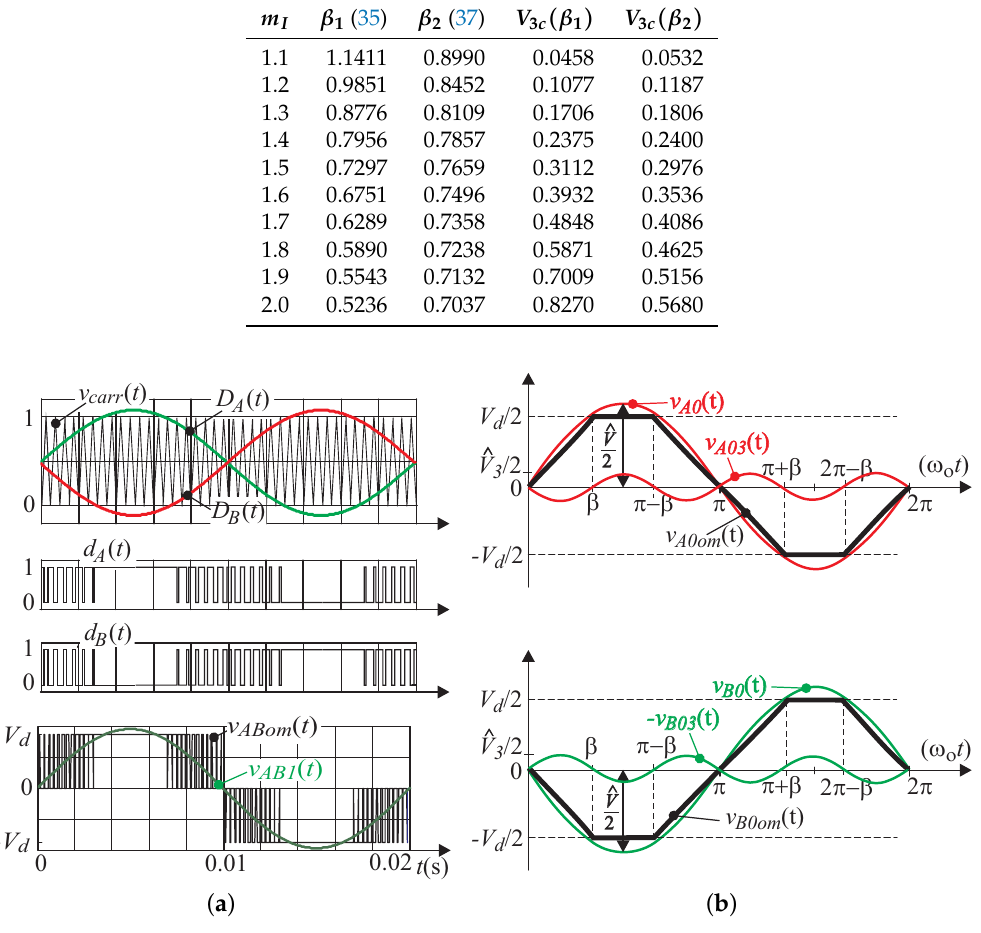
Figure 5. Over-modulation procedure: ( a ) Triangular carrier signal and duty cycle functions D A ( t ) and D B ( t ) ; switching function waveforms d A ( t ) and d B ( t ) and over-modulated output voltage v ABom ( t ) and its first harmonic component v AB 1 ( t ) and ( b ) Modified desired half-bridge voltages v A 0 om ( t ) and v B 0 om ( t ) .